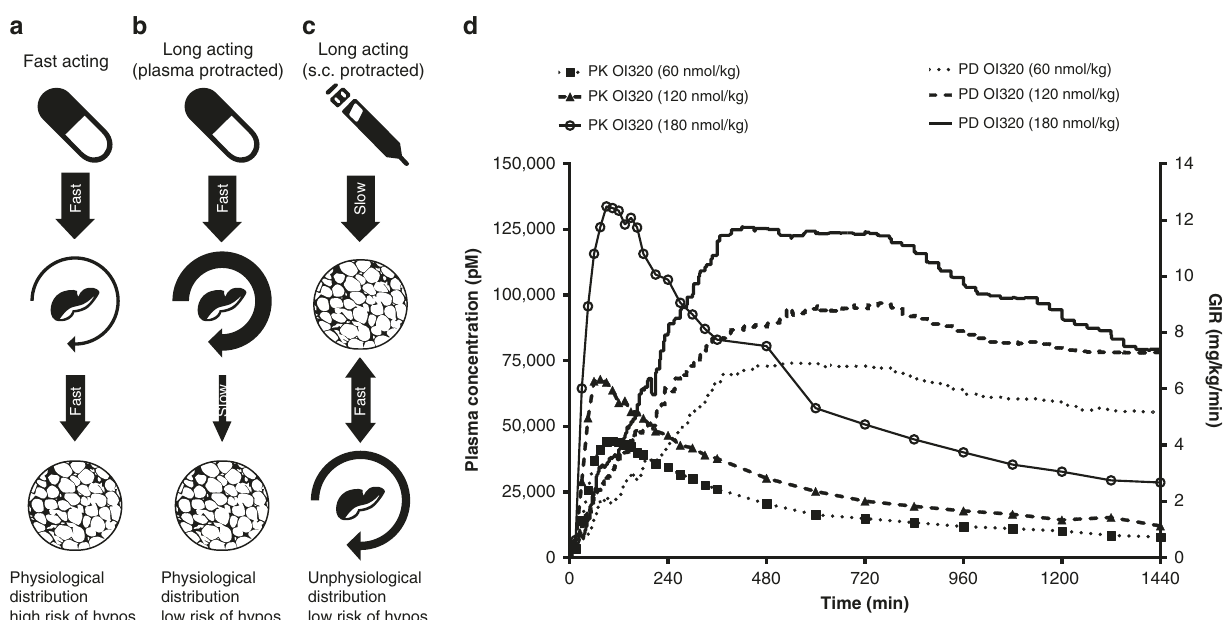
Fig. 5 Schematic overview of insulin levels, distribution kinetics and the kinetic/dynamic relationship. a – c Schematic overview of insulin levels (arrow width) and distribution kinetics upon a oral dosing of fast acting insulin (e.g. human insulin), b oral dosing of a plasma protracted insulin (e.g. OI338 and OI320), and c SC dosing of a long acting insulin, which is protracted SC (e.g. insulin glargine or insulin degludec, or OI338/OI320 dosed SC). d The pharmacodynamic time course (GIR = glucose infusion rate required to maintain euglycemia) of orally dosed OI320 and pharmacokinetic exposure during hyperinsulinemic euglycemic clamp in healthy and conscious dogs. Note the long lag time of pharmacodynamic effect in respect to exposure. The CV for the GIR AUC was in the range 45 – 80% and for the pharmacokinetic AUC the CV was 45 –